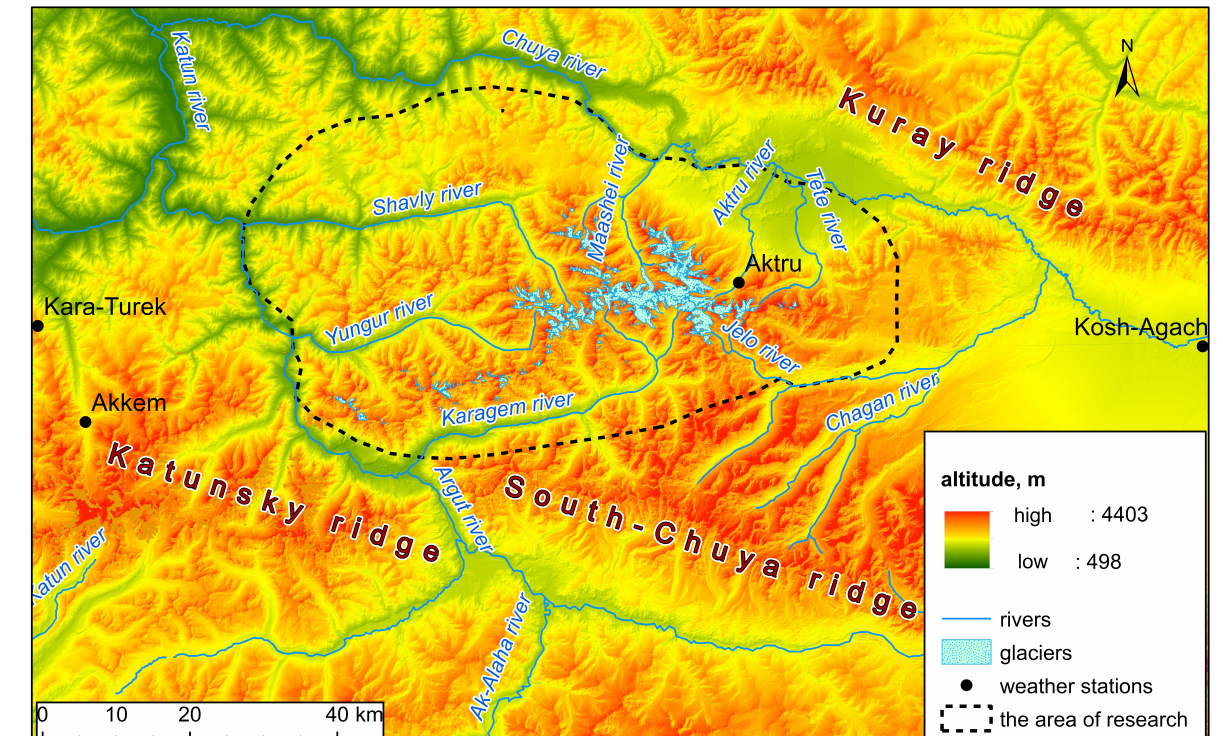
Figure 2. The nearest meteorological stations and river basins of the North-Chuya ridge. All altitudes are given based on the 30 m SRTM 1 Arc-Second Global DEM